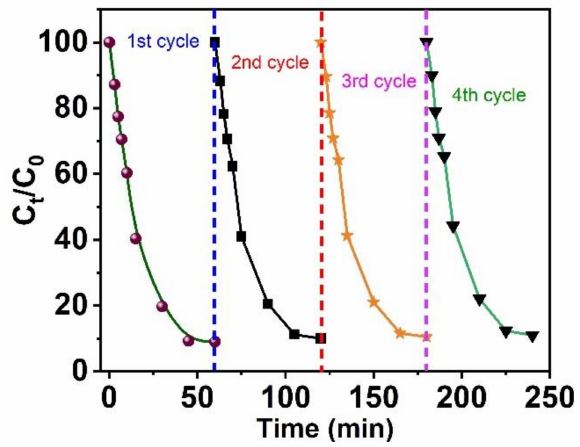
Figure 11. Photocatalytic cycling stability of Ru-ZnO@g-C 3 N 4 photocatalyst nanoparticles.